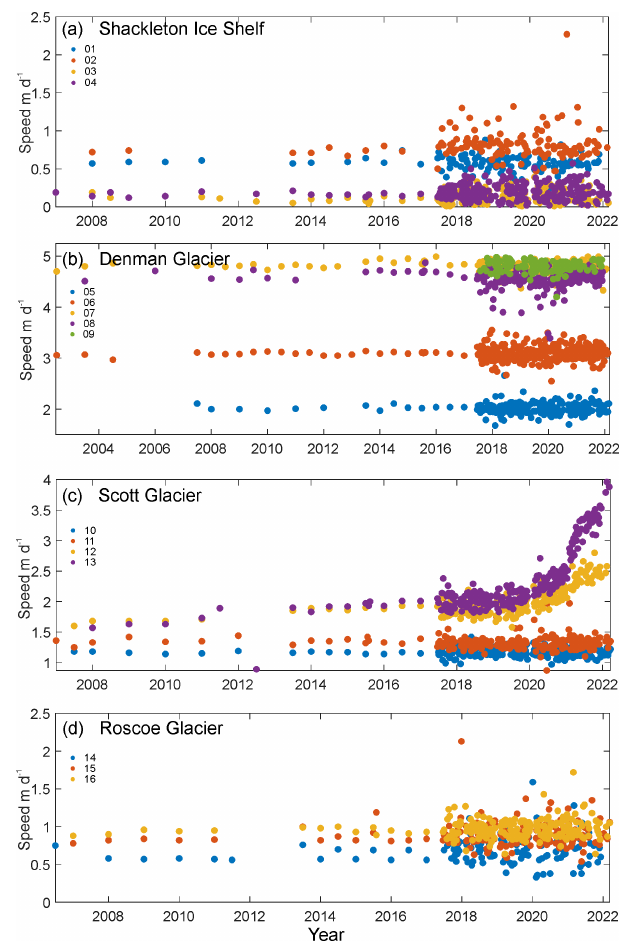
Figure 11. Time series of speed at point locations (shown in Fig. 10a) across the Shackleton system derived from Sentinel 1 between 2017 and 2021 (uncertainties in velocity magnitude are around 0.2md − 1 following Benn et al., 2019) and extended back to 2002 using MEaSUREs and ITS_LIVE where available (Rignot et al.,